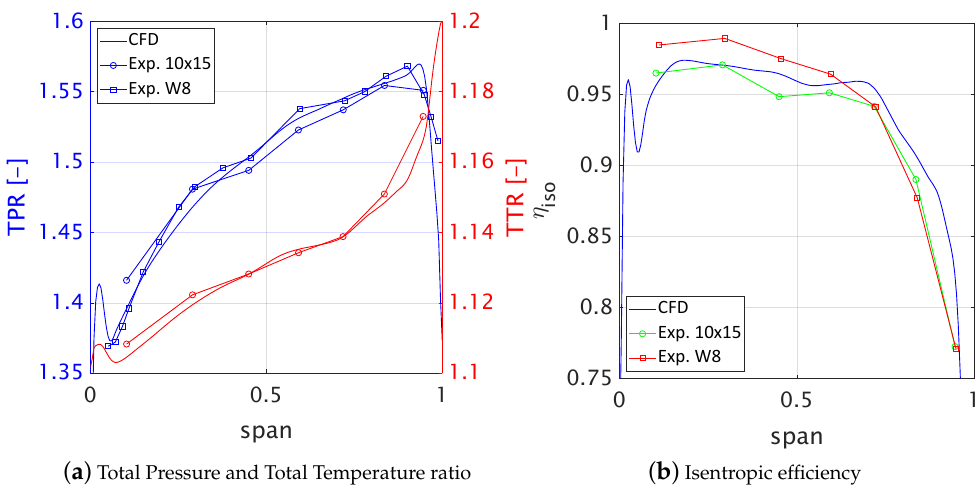
Figure 6. Comparison of experimental and calculated circumferential-averaged spanwise profiles downstream of rotor blade for fan+OGV single-point take-off